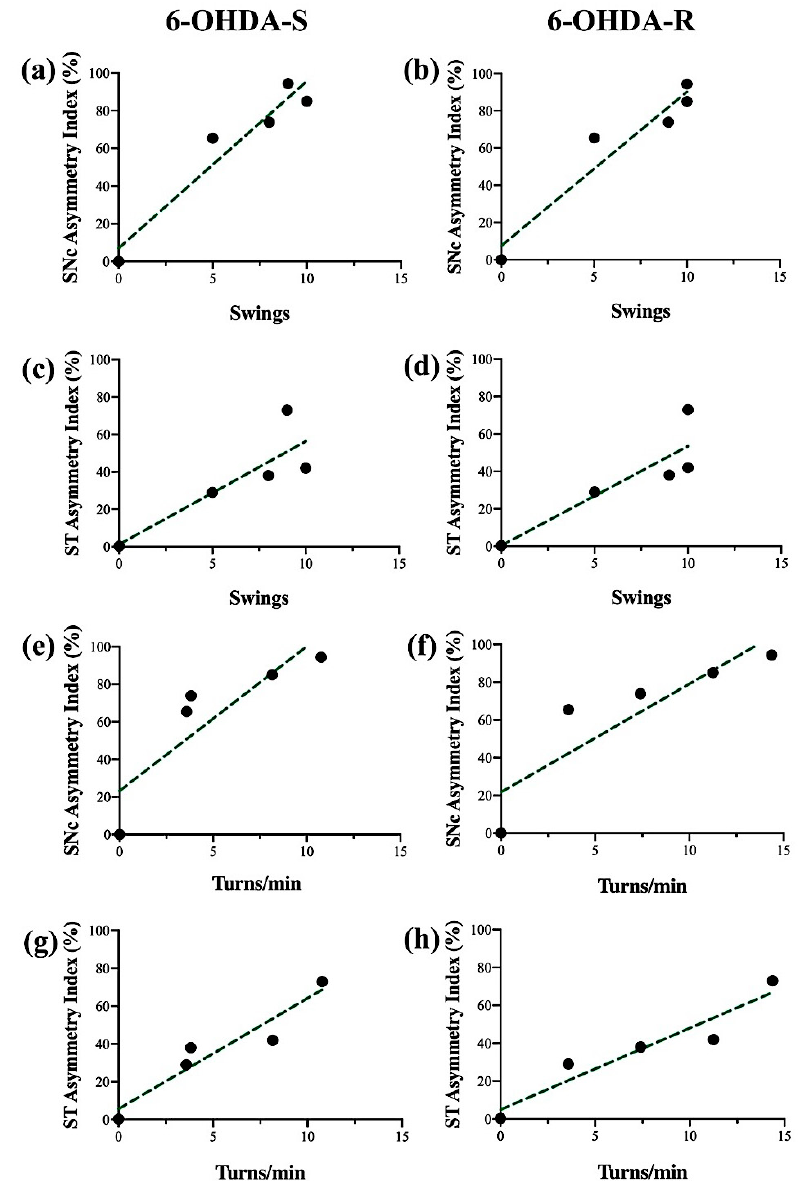
Figure 5. Regression analysis of contralateral TSST swings ( a – d ) and RT turns / min ( e – h ) versus the SNc asymmetry index % nigral cell loss ( a , b ; e , f ) and ST asymmetry index % terminal fiber loss ( c , d ; g , h ) for the animals subjected to single (6-OHDA-S, left column) and repeated (6-OHDA-R, right column) apomorphine administration.